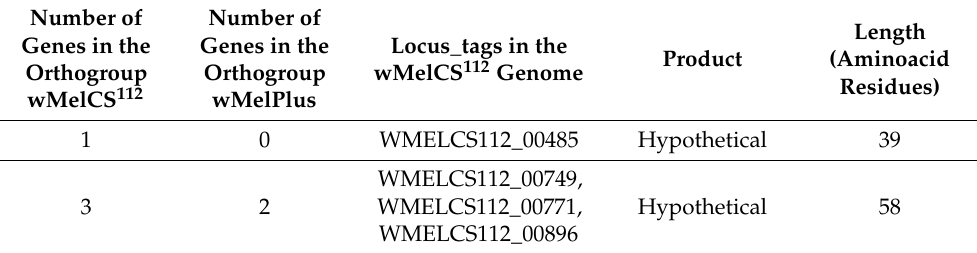
Table 2. The differences in the number of genes in orthogroups between the wMePlus and wMelCS 112 Wolbachia